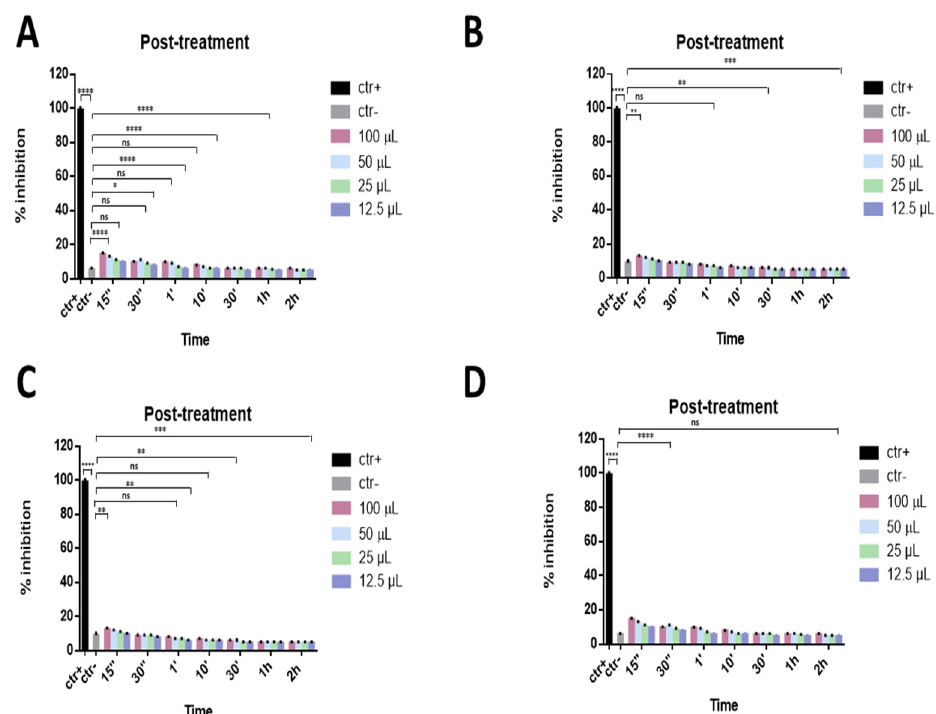
Figure 5. Post-treatment assay. Antiviral activity against SARS-CoV-2 of eye drops at different times of stimulation. Cells were first infected with SARS-CoV-2 and then treated with Iodim ( A ), Ozodrop ( B ), Dropsept ( C ), and Septavis ( D ). Iodim, Ozodrop, Dropsept, and Septavis were not able to act on the viral replication mechanism. * p = 0.001; ** p < 0.001; *** p = 0.0001; **** p < 0.0001; ns: non-significant.